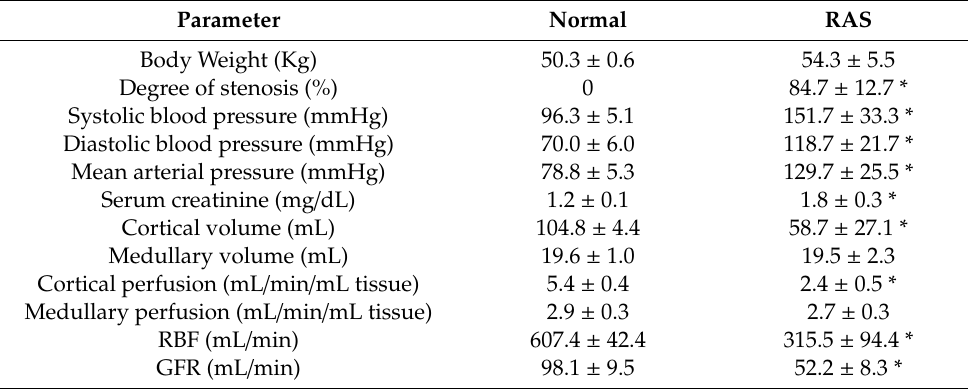
Table 1. Systemic characteristics and renal function at 10